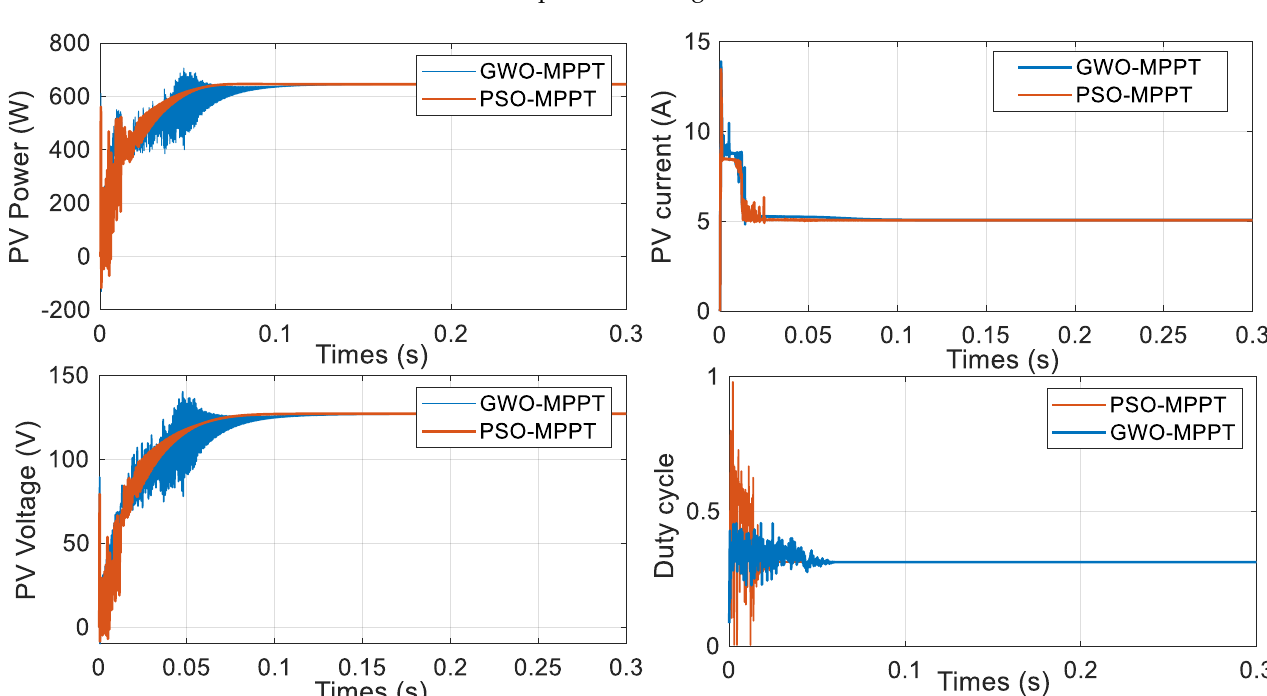
Figure 11. PV characteristics under partial shading: (600 W/m 2 , 600 W/m 2 , 1000 W/m 2 , 1000 W/m 2 ). C. Second case of partial shading.